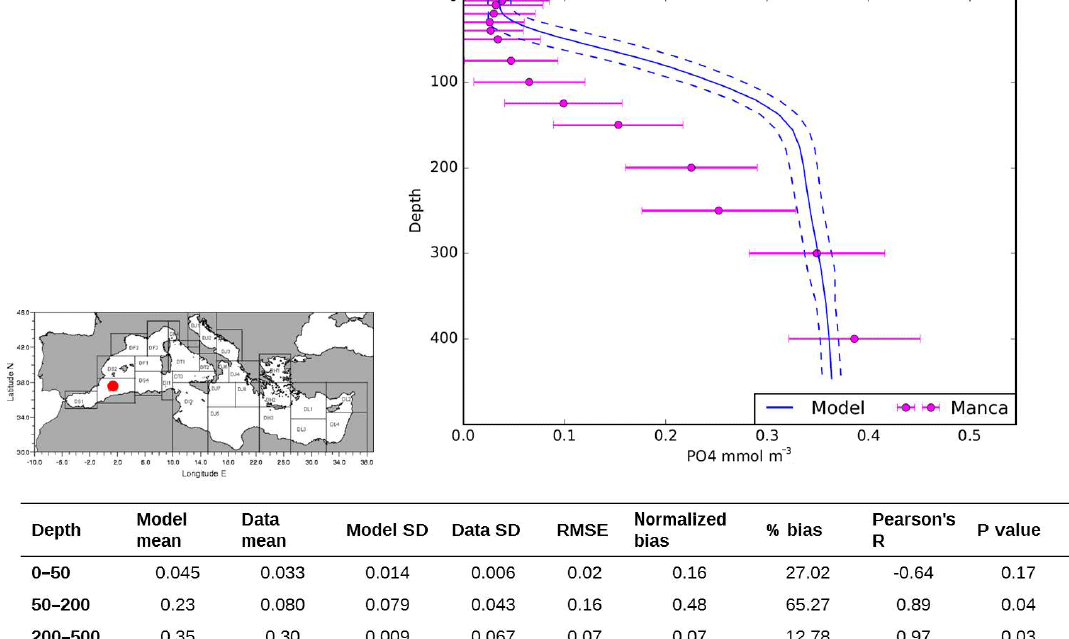
Figure A1. Annually averaged PO 4 vertical profile in the Algerian sub-basin (see map and Manca et al., 2004) and statistical indicators over different depths. Model values are shown with the blue line (2005 average, Ntot simulation from Richon et al., 2017) and measured values from Manca et al. (2004) are in pink. Horizontal bars and dashed lines indicate the spatial SD of observations and model results respectively.